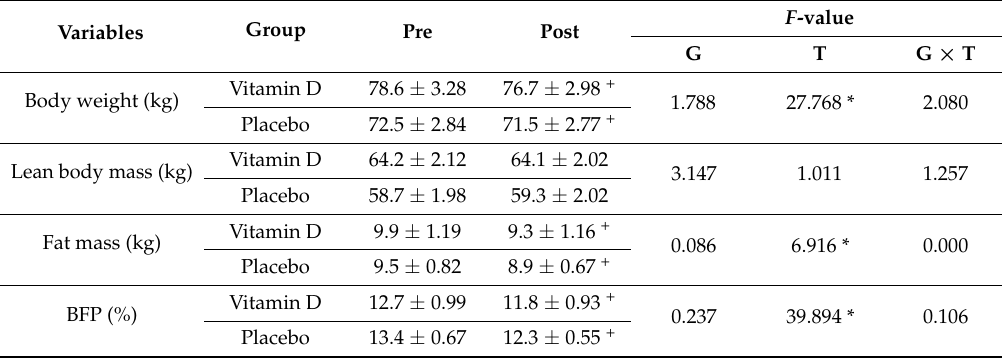
Table 1. Changes in body composition variables during 4 weeks of winter